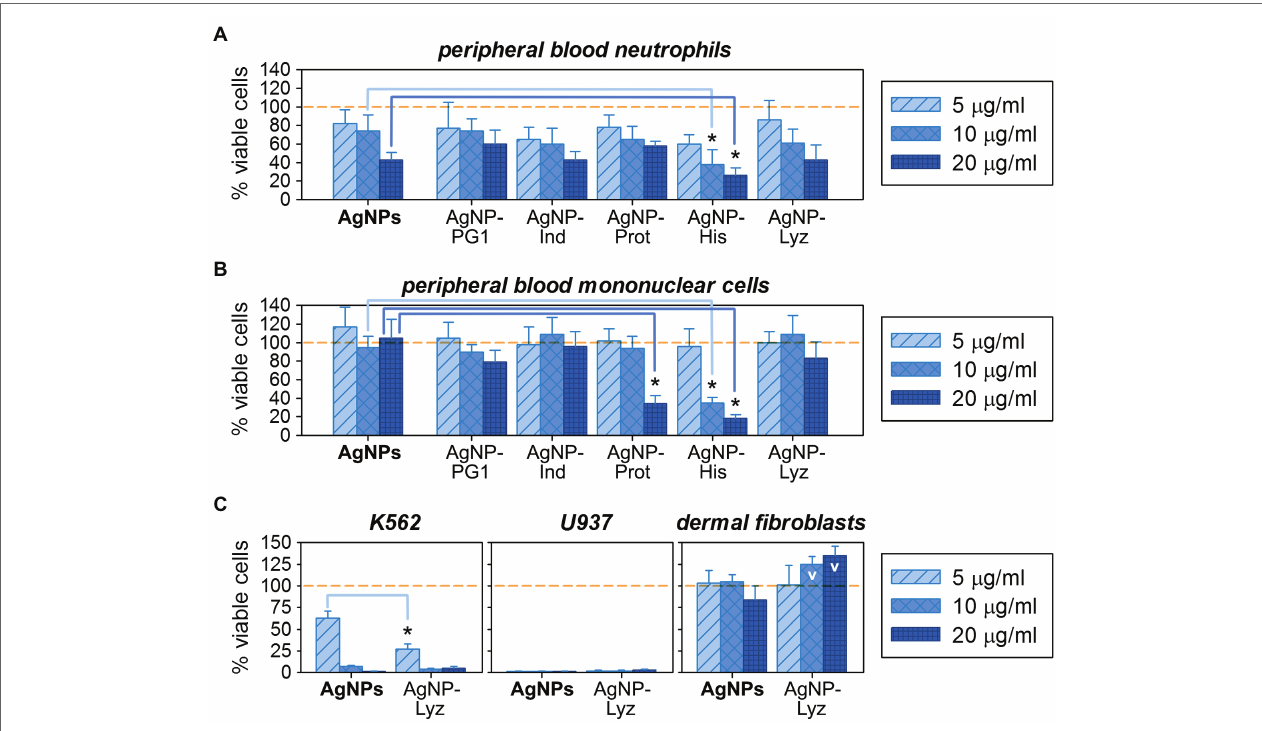
FIGURE 5 | Comparative cytotoxic activity of gelatin-only coated silver nanoparticles (AgNPs) and their conjugates with antimicrobial peptides and proteins (AMPs) on eukaryotic cells: on normal human peripheral blood neutrophils (A) and mononuclear cells (B) ; on human cancer cell lines K562 and U937, as well as on normal human dermal fibroblasts (C) . Mean ± standard deviation values were calculated based on 3–4 independent MTT-tests performed in triplicate. Cases of significantly increased toxicity compared to the same concentration of unconjugated AgNPs are marked with asterisks (Mann–Whitney U-test, p < 0.05); cases of statistically significant increase of the presumed viable cell number over the non-treated control (100% viable cells) are denoted with V (Mann–Whitney U-test, p <